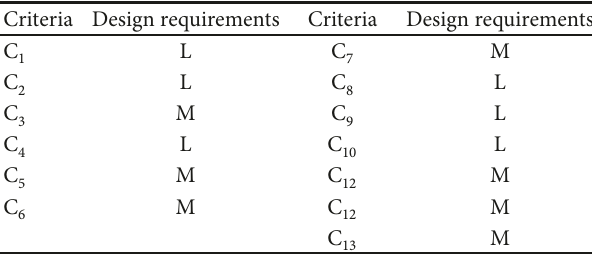
Table 5: Design requirements for the criteria.